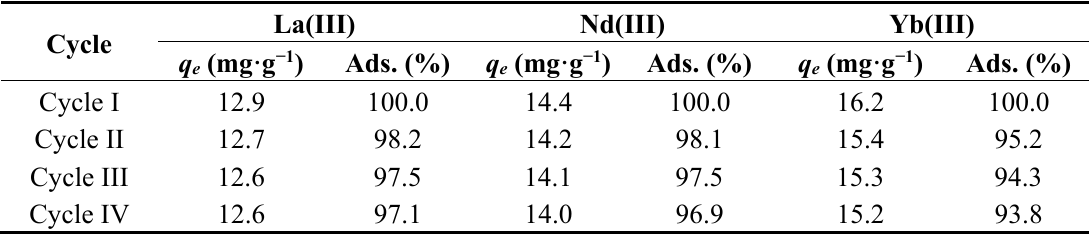
Table 7. Recycling of cysteine-based magnetic-chitosan nano-based particles for the sorption of La(III), Nd(III) and Yb(III) metal ions over four cycles.